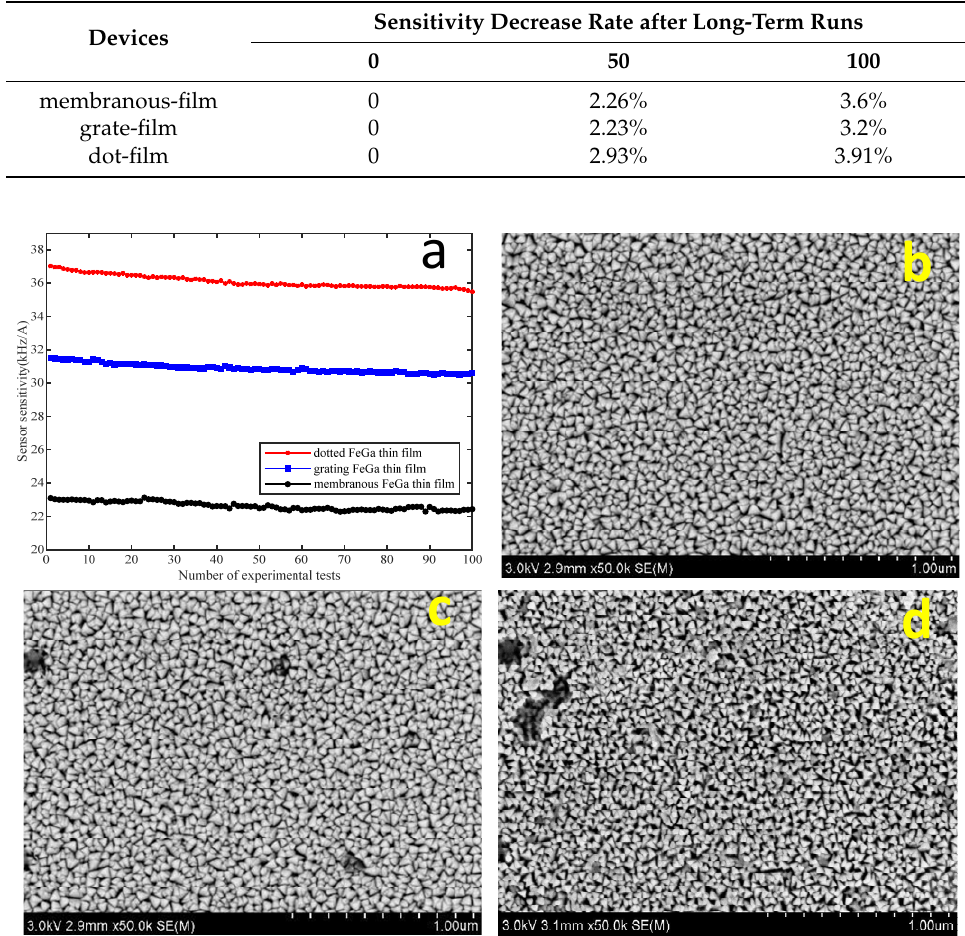
Figure 10. ( a ) The fatigue measurement of developed SAW sensing devices, and the surface mor- phologies of the FeGa thin film in different cyclic testing runs of ( b ) 0, ( c ) 50, and ( d )